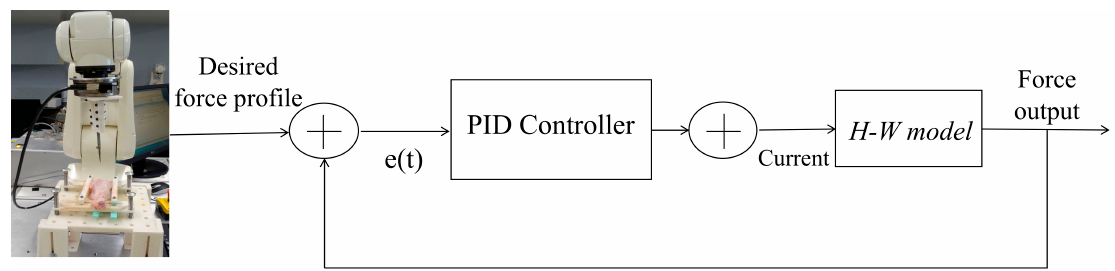
Figure 7. Control loop design using a nonlinear H-W model to estimate output force.